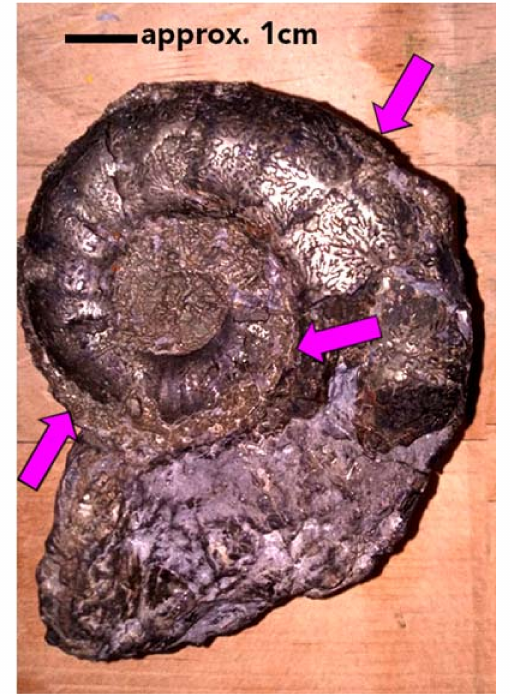
Figure 7. A Lytoceras cornucopia specimen which has undergone taphonomic lateral compaction and whose only fully intact suture elements are L and S 2 . The arrows indicate crushing of the external lobe (E) distalmost umbilical lobes (U 1